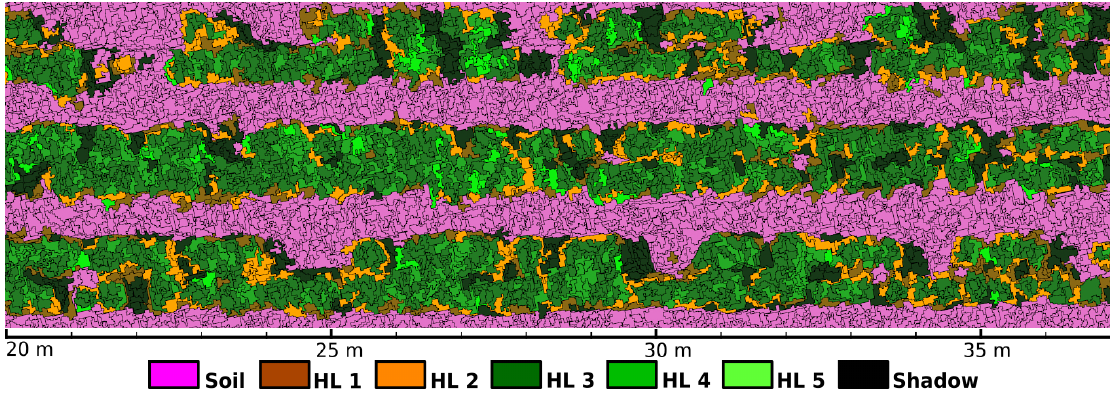
Figure 4. Maximum likelihood classification of